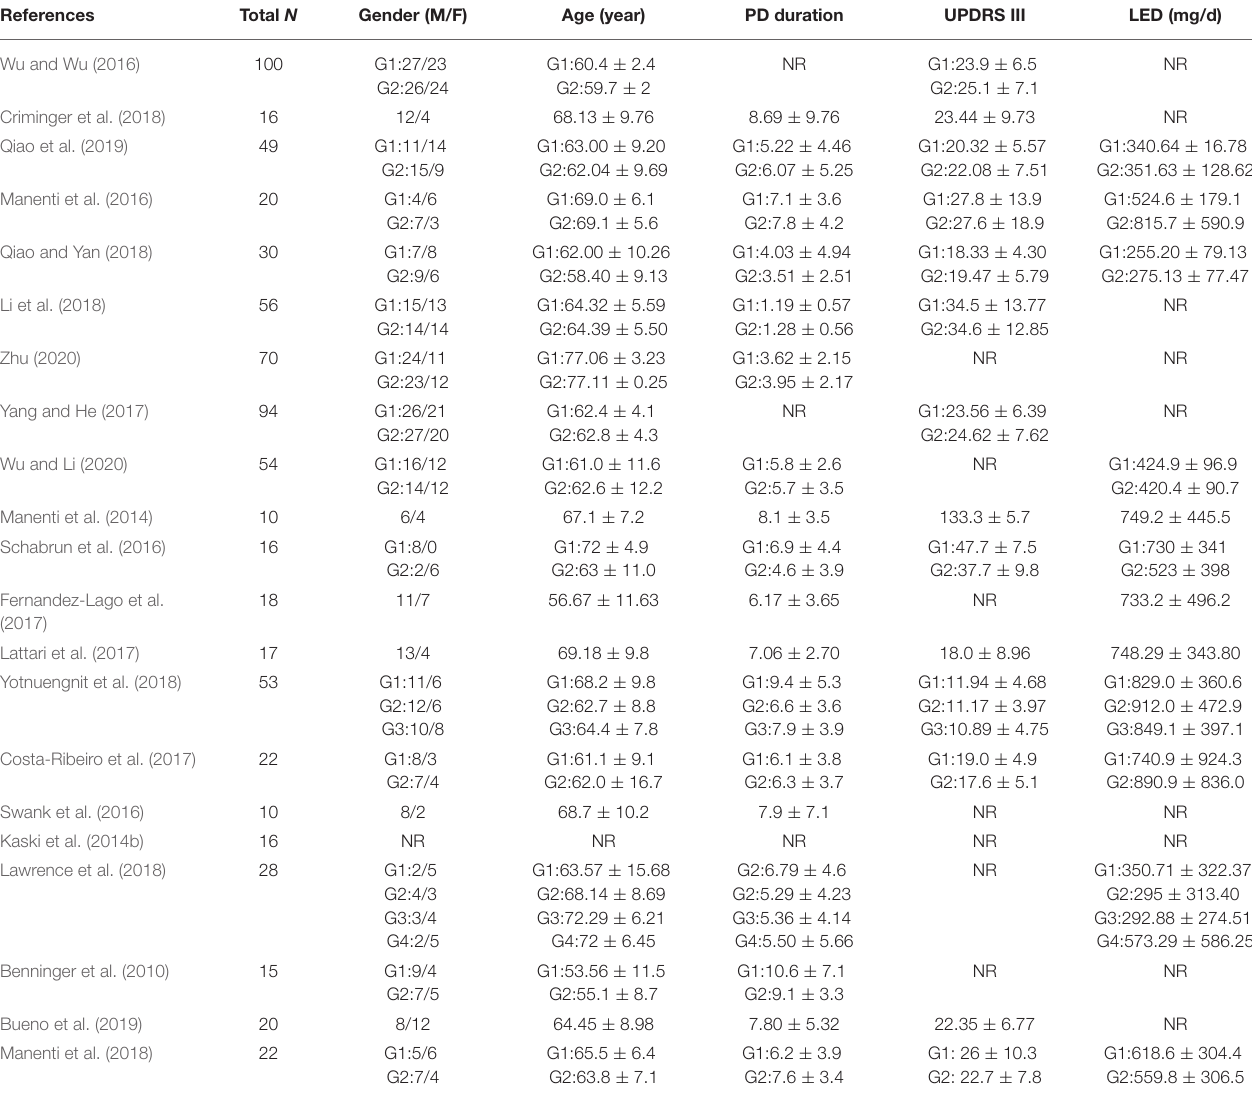
TABLE 1 | Characteristics of participants included in the